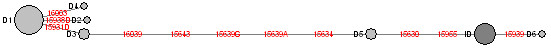
Median-joining network of dog mtDNA haplotypes belonging to haplogroup D. Haplotypes D1, D2, D3 and D4 were observed in Scandinavian dogs, while D5 was observed in Turkey, D6 in Spain and ID in this work. Circle sizes are proportional to the number of individuals they represent.